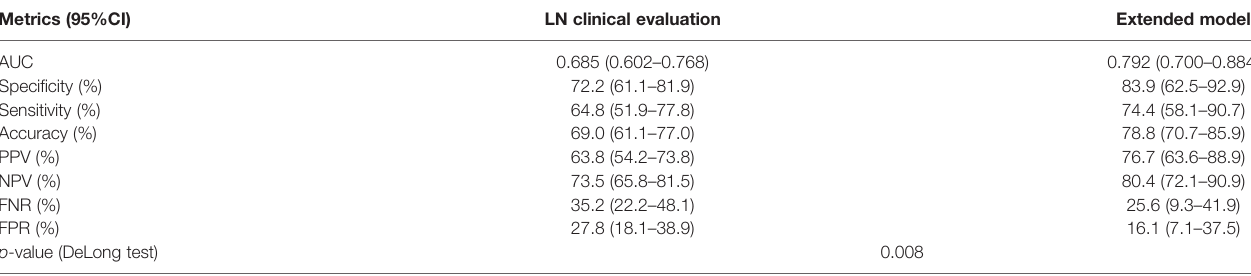
TABLE 5 | Metrics assessing the performance of the proposed methods for the prediction of lymph node metastasis. Metrics